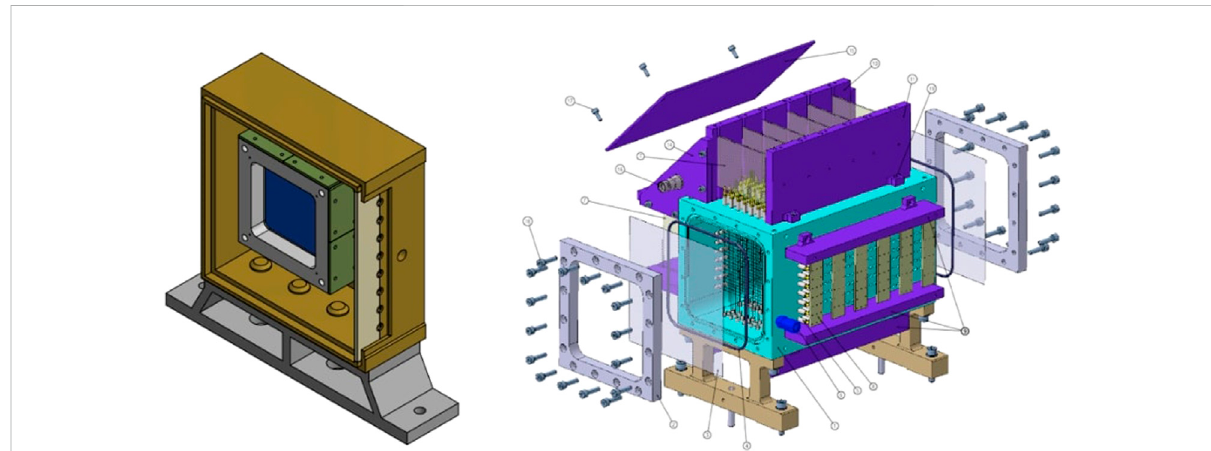
FIGURE 2 (Left) Start Counter detector inside the plastic box. The aluminum mechanical structure holds the EJ-228 plastic scintillator foil (in dark blue). (Right)TechnicaldrawingoftheBeamMonitordriftchamber.Thetwoorthogonalviewsofthewiresareclearlyvisible.Twoenclosingmylarwindows fi xed by aluminum frames are shown as well [22]. In both representations the axes are: X horizontal perpendicular to beam, Y vertical, Z along the